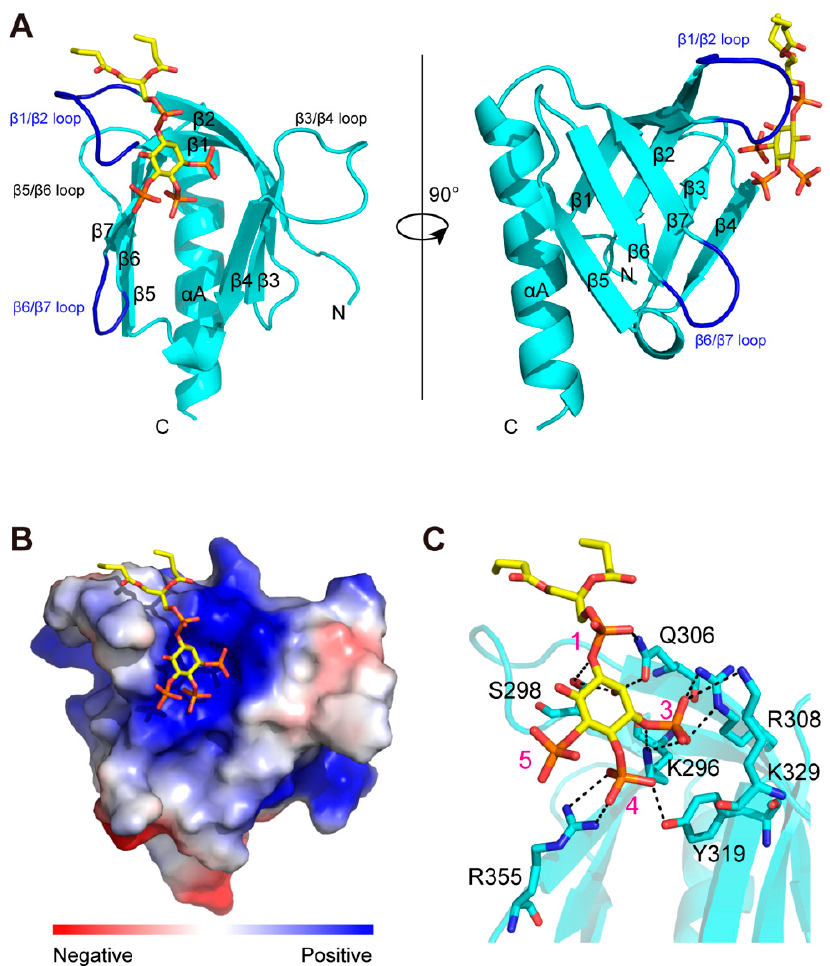
Figure 2. Structure of the Arap3-PH1 domain in complex with diC4-PI(3,4,5)P3. ( A ) Cartoon diagram of Arap3-PH1 complexed with diC4-PI(3,4,5)P3. Arap3-PH1 is colored turquoise, with secondary structures labeled. The loops of β 1/ β 2 and β 6/ β 7 that interact directly with diC4-PI(3,4,5)P3 are colored blue. The diC4-PI(3,4,5)P3 (gold) is shown in stick mode. ( B ) Surface electrostatic potential of Arap3-PH1 complexed with diC4-PI(3,4,5)P3. Blue areas, positive; red areas, negative. ( C ) Detailed interactions of the diC4-PI(3,4,5)P3 with Arap3-PH1 domain. The side chains of crucial residues are shown in stick mode and labeled, respectively. The phosphate groups on diC4-PI(3,4,5)P3 are also labeled. Selected hydrogen bonds or salt bridges are shown as dotted